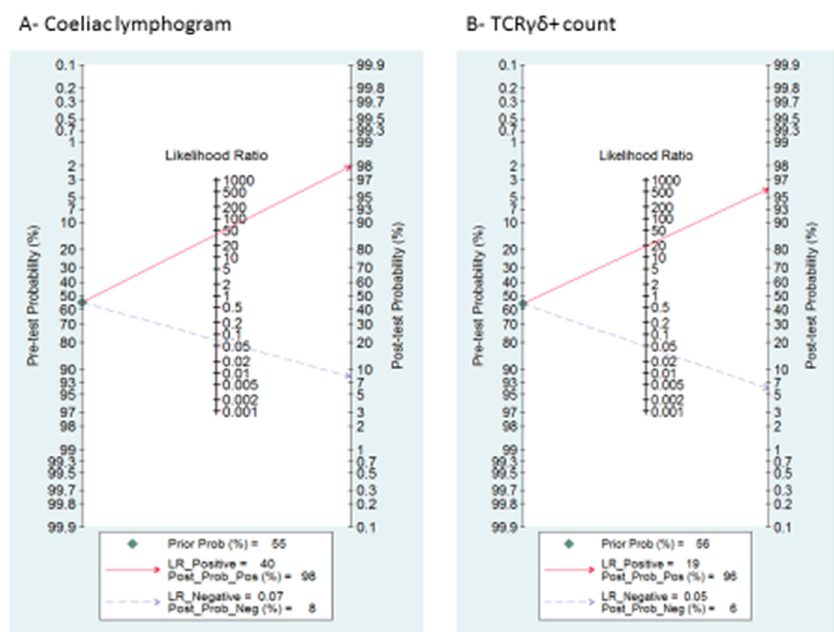
Figure 4. Fagan’s nomogram for the elucidation of post-test probabilities. With a pre-test probability of CD of 55%, the post-test probabilities of CD, given positive and negative index test, were: ( A ) coeliac lymphogram: 98% and 8%, respectively; and ( B ) TCR γδ + : 96% and 6%, respectively. + TCR γδ IEL: Pooled sensitivity (Figure 5) was 95% (95% CI, 82–99%) with significant heterogeneity ( I 2 = 95.6%; p < 0.001). Pooled specificity (Figure 5) was 95% (95% CI, 91–97%), with heterogeneity ( I 2 = 62%; p = 0.05). The SROC curve is described in Figure 3B, being the AUROC of 0.97 (95%, 0.95–0.98), which implies a high diagnostic accuracy for diagnosing CD.